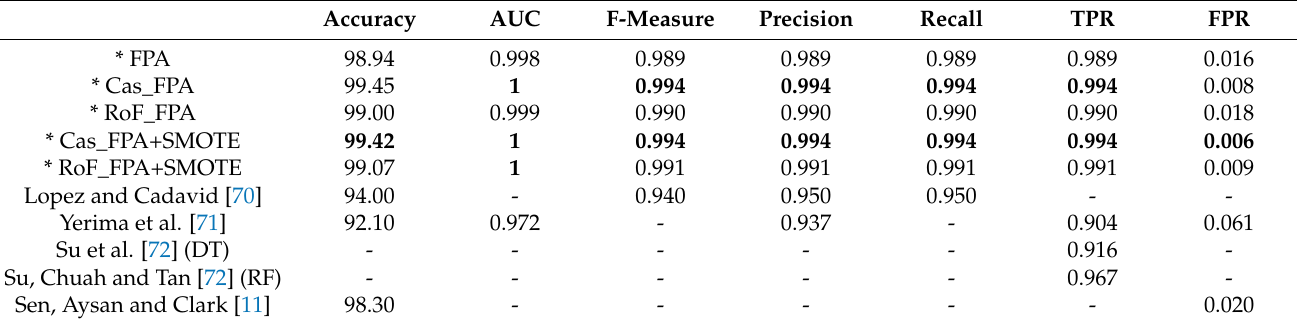
Table 14. Detection performances of proposed methods and existing models on the Malgenome